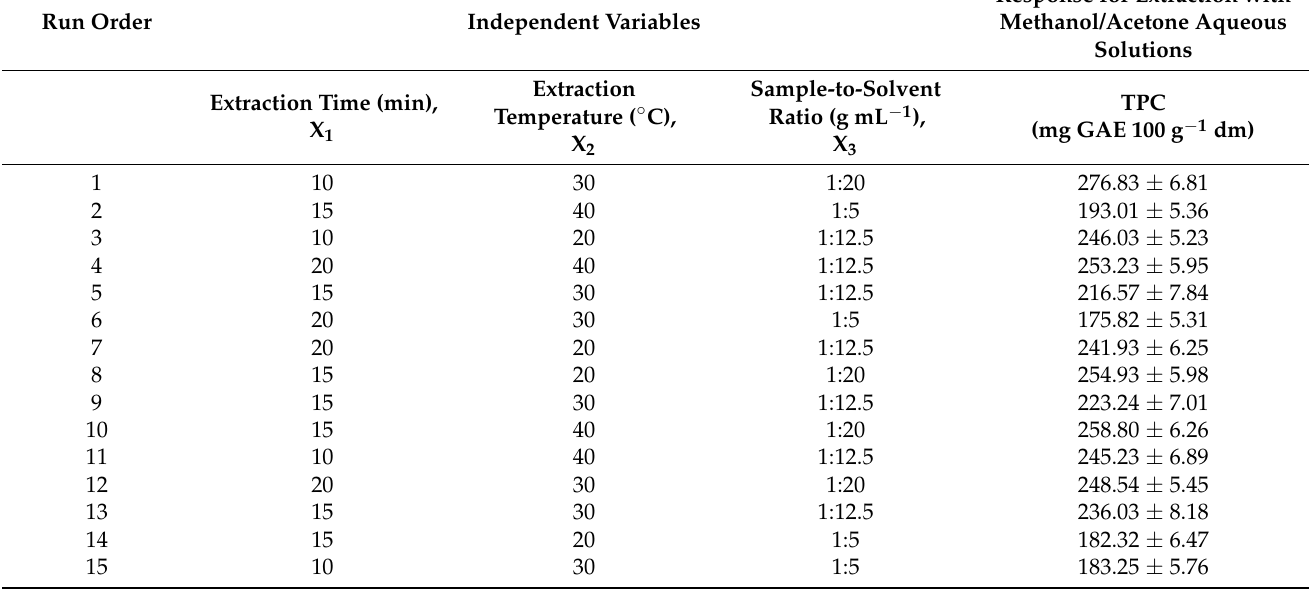
Run Order Independent